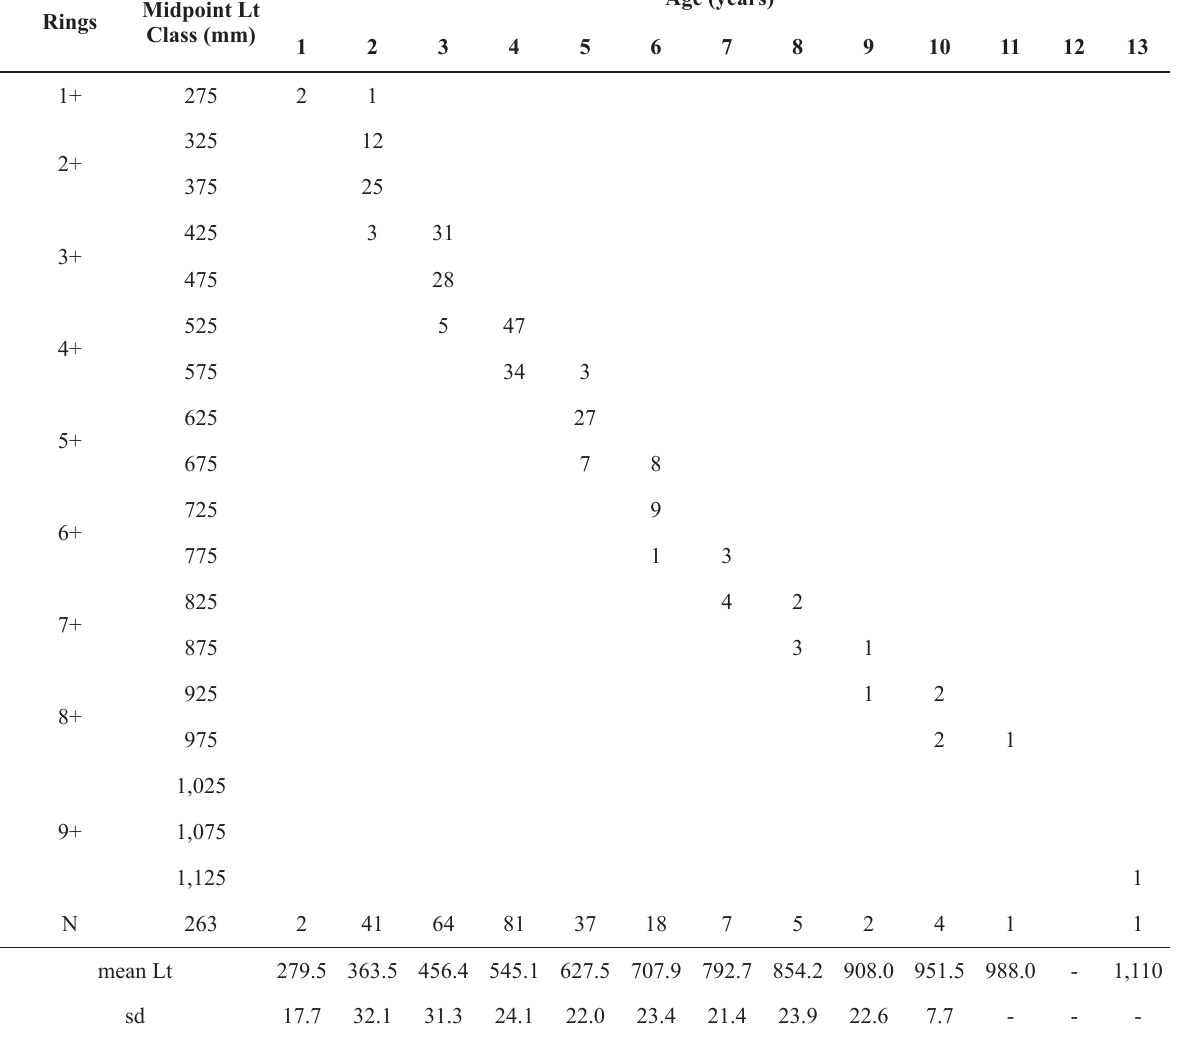
Age-length keys for females and males of the pink cusk-eel Genypterus brasiliensis . Females